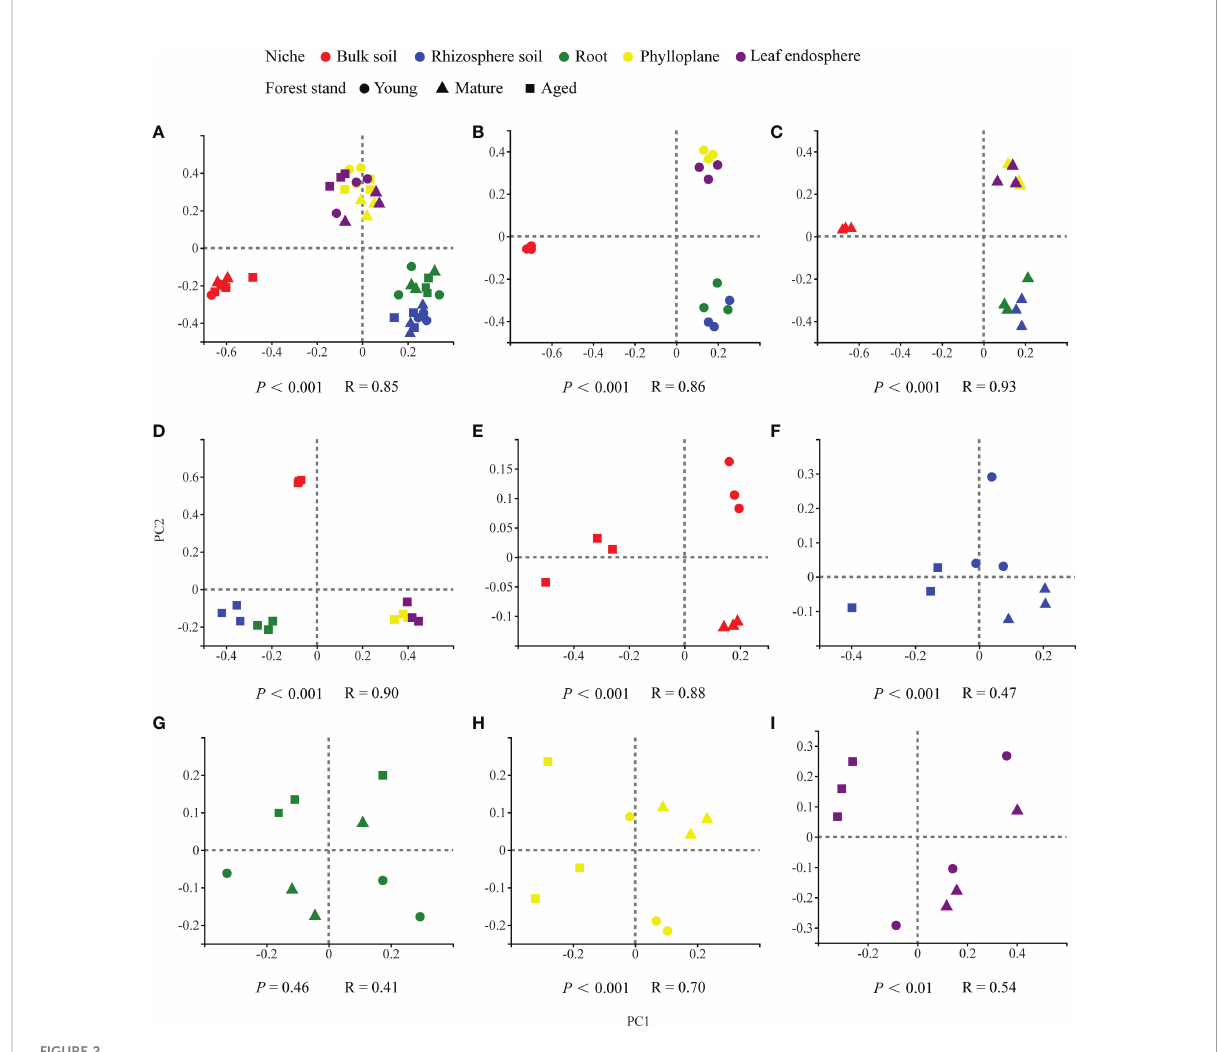
FIGURE 2 PCoAordinations basedonselected distancematrices offungal communities in each compartment niches fromsamples ( n = 45). (A) all samples; (B) young forest stand; (C) mature forest stand; (D) aged forest stand; (E) bulk soil; (F) rhizospheresoil; (G) root; (H) phylloplane; (I) leaf